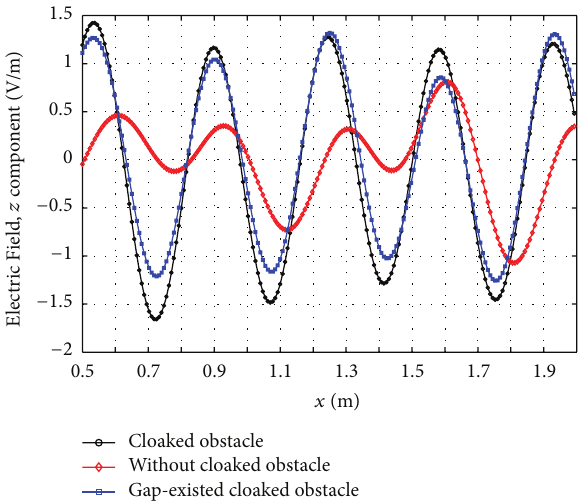
Figure 10: The comparison of signal strength in the shadow